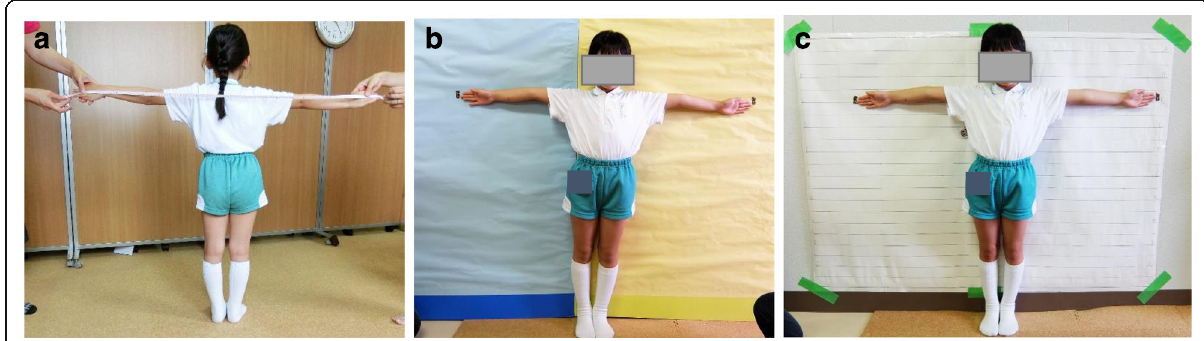
Fig. 1 The methods of arm span measurement. a No-Wall. With heels together, the child stretches the arms out to the sides. b Wall & No-Line. The child stands against the wall with heels together and spreads the arms against the wall. c Wall & Line. The method is the same as B except that a paper with horizontal lines is placed on the